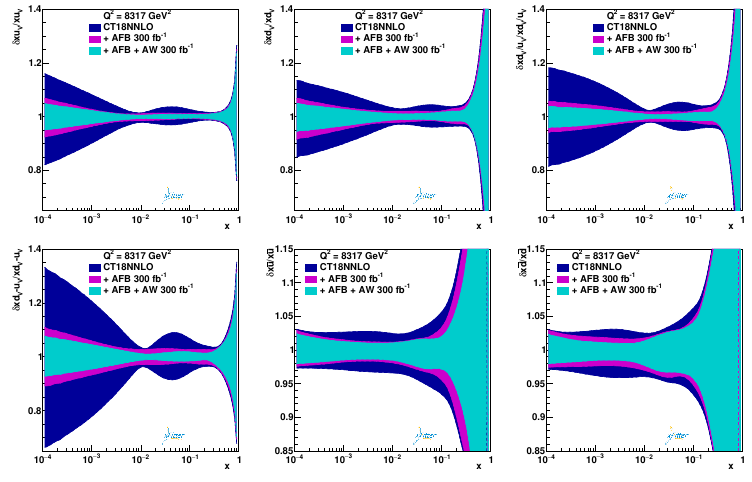
Figure 1: Original CT18NNLO [ 13 ] (blue) and profiled distributions of selected PDFs using either A (pink) or both A and A (cyan) pseudodata corresponding to an FB FB W integrated luminosity of 300 fb − 1